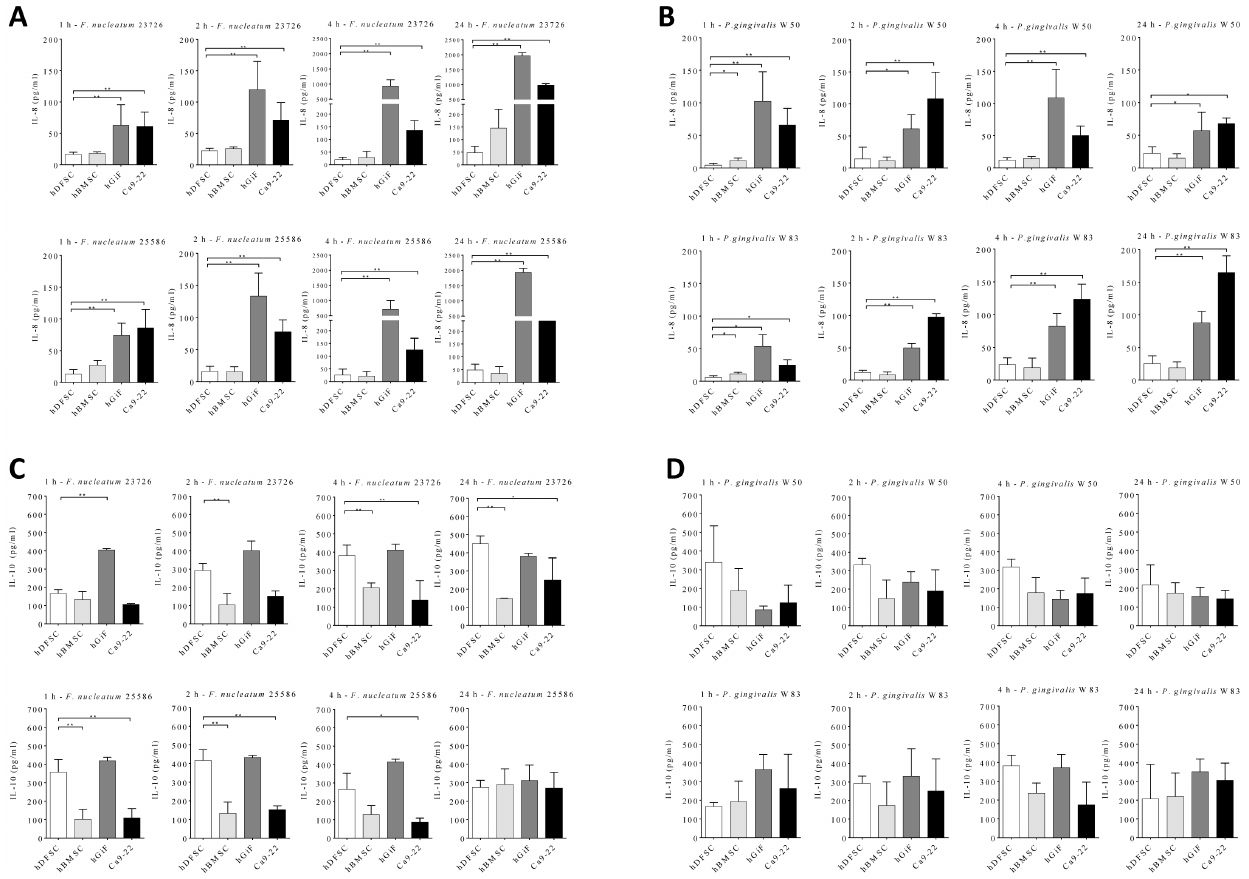
Figure 4. IL-8 and IL-10 secretion. The assays were carried out as described in the text. IL-8 and IL-10 levels were assayed by ELISA. Absorbance was read at 450 nm. Values represent the means 6 SD, *p , 0.05, **p=0.01 (T-test), n=4. Asterisks indicate statistically significant differences between hDFSC and hBMSC, hGiF, and Ca9-22. Cytokine secretion by hDFSC was compared with secretion by hBMSC, hGiF, and Ca9-22 cells at the same timepoint. A ) IL-8 measured in the supernatant of the F.nucleatum ATCC 23727 and 25586 co-culture after 1, 2, 4, and 24 h. B ) IL-8 measured in the supernatant of the P. gingivalis W50 and W83 co-culture after 1, 2, 4, and 24 h. C ) IL-10 measured in the supernatant of the F.nucleatum ATCC 23727 and 25586 co-culture after 1, 2, 4, and 24 h. D ) IL-10 measured in the supernatant of the P. gingivalis W50 and W83 co-culture after 1, 2, 4, and 24 h.